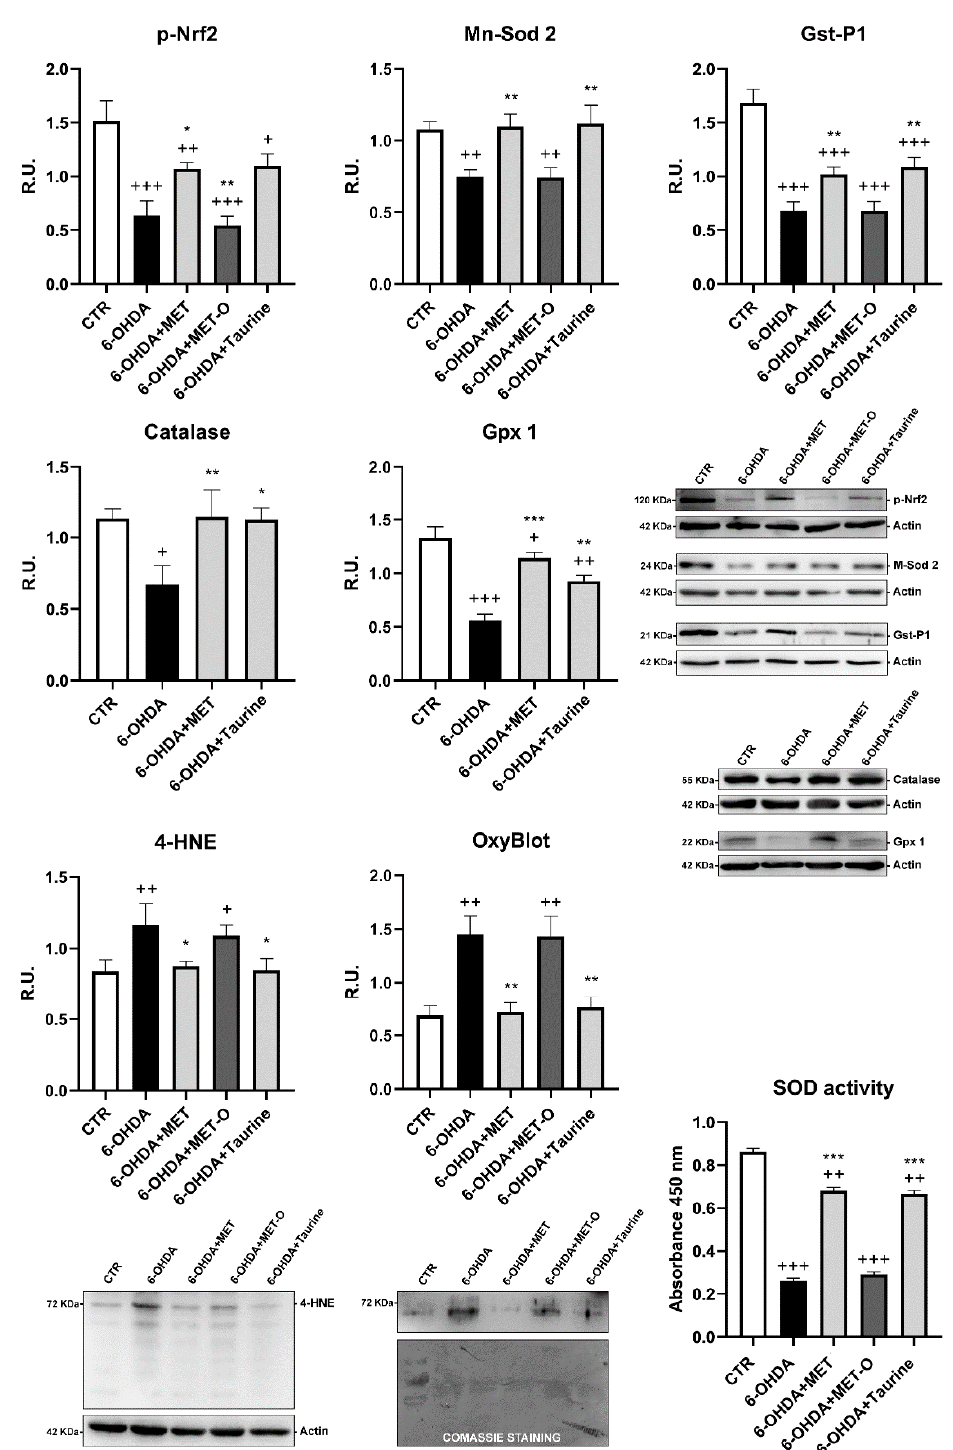
Figure 6. Antioxidant pathway analyzed by WB analyses, Oxyblot detection kit, and SOD activity assay. A representative WB figure is shown. Data are mean ± SD of 3 different experiments. *** p < 0.0001, ** p < 0.005, * p < 0.05 vs. 6-OHDA; +++ p < 0.0001; ++ p < 0.005; + p < 0.05 vs. CTR.